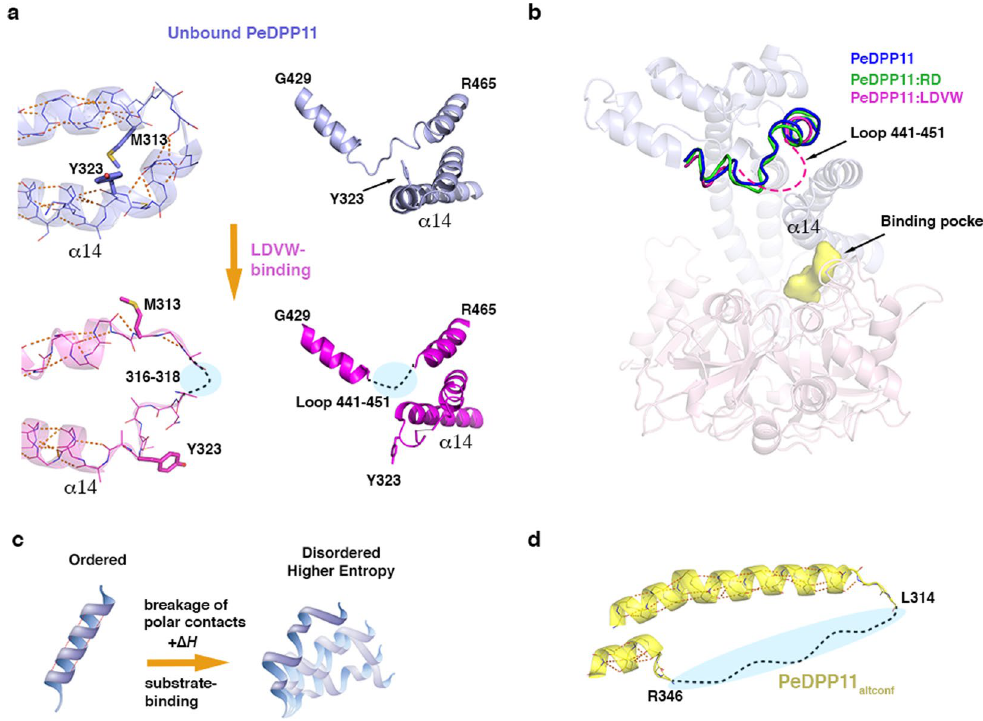
Figure 4. PeDPP11 conformational changes. (a) Close-up view of the main PeDPP11 regions that unfold upon binding to LDVW, as observed in the crystal structures. (b) Loop F441-K451 region superposition of unbound PeDPP11 (blue), PeDPP11:LDVW (magenta, dashed line) and PeDPP11:RD (green). Unbound PeDPP11 is represented as ribbons and peptide binding pocket as yellow surface. (c) Cartoon representation depicting a DPP11 helix unfolding. Upon substrate binding, energy is absorbed from the solution to break polar contacts, which causes helix destabilization. In the disordered stage, the helix accesses different structural states, increasing system entropy. (d) Close-up view of the helix α 14 missing region in PeDPP11 altconf . Intra-main chain polar contacts are indicated with orange dashed